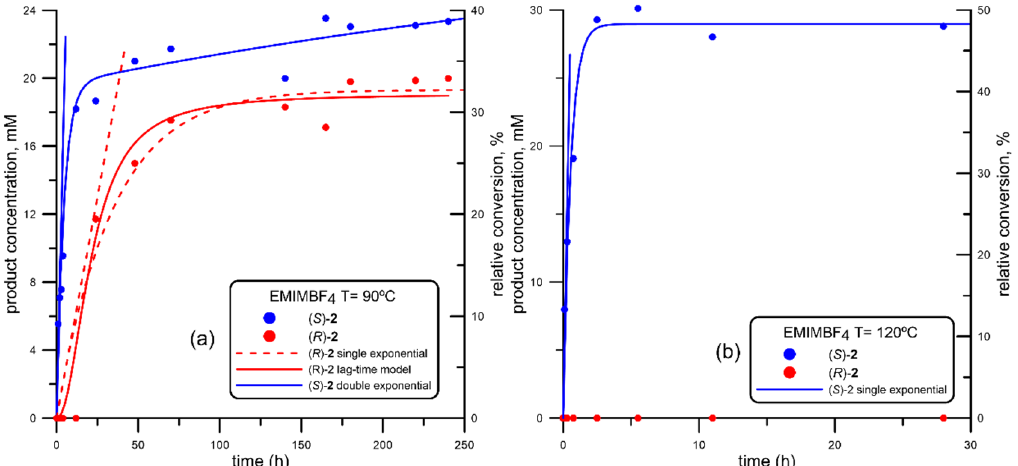
Figure 4. Progress curve of the BTL2-catalyzed production of both enantiomers of mandelic acid (( R )-